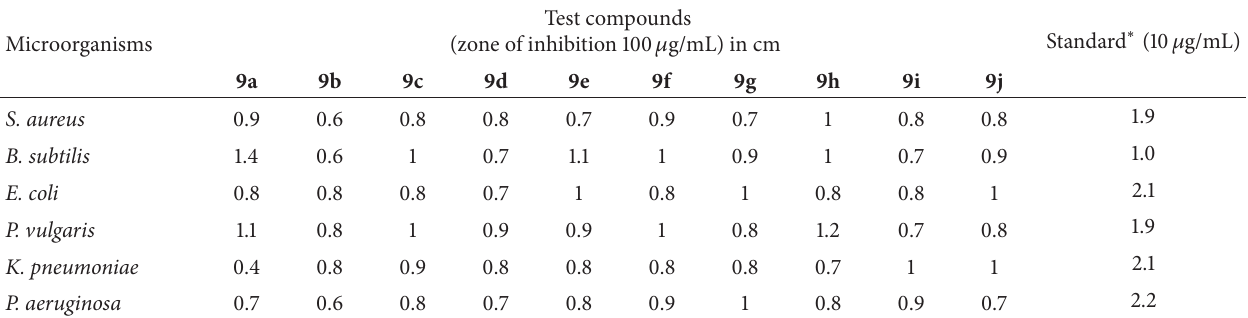
Table 1: Antibacterial activity (zone of inhibition) of newly synthesized 3-(substituted)-2-(4-oxo-2-phenylquinazolin-3(4H)-ylamino)qui- nazolin-4(3H)-ones ( 9a–9j ).